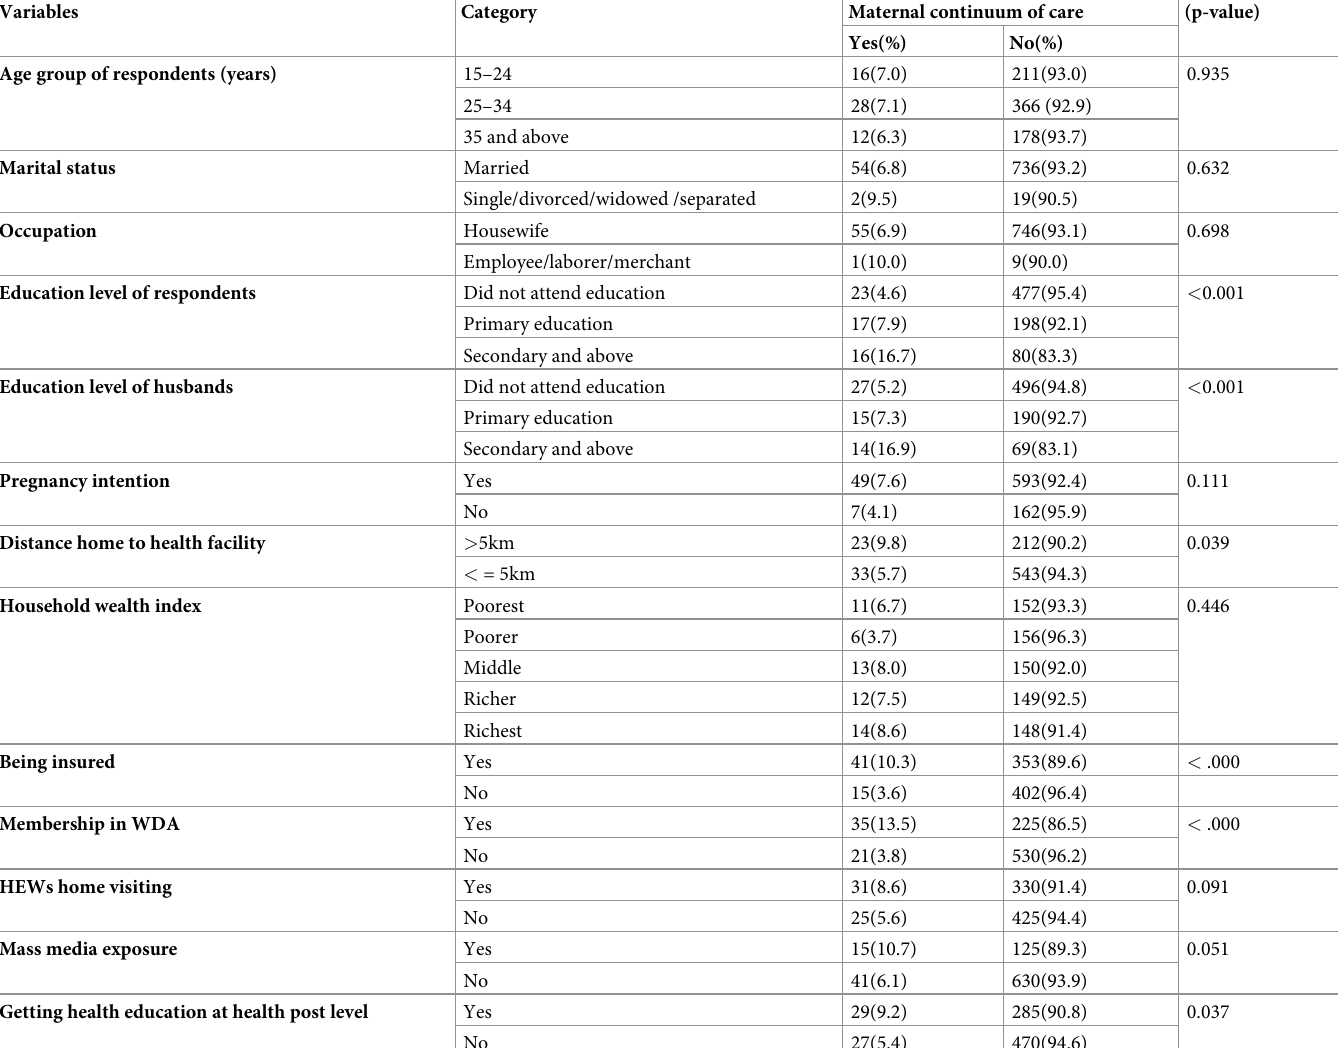
Table 1. Sociodemographic and reproductive characteristics of study participants in Northwest Ethiopia, 2020 (n =